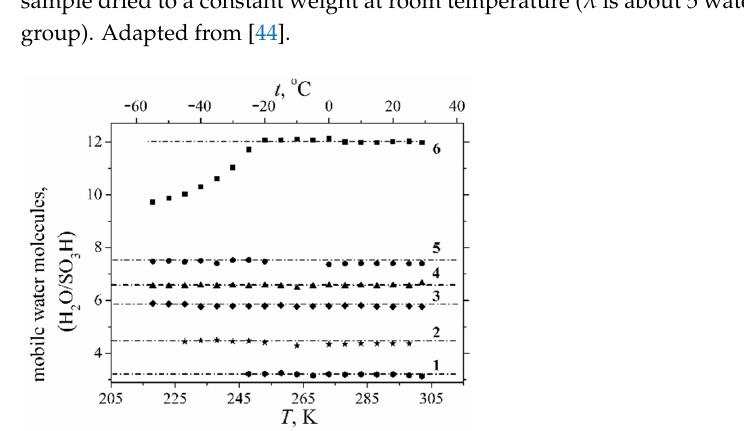
Figure 16. Dependences of the mobile water molecule amount in the acidic form of the Nafion 117 membrane on temperature at different water contents: (1) λ = 3.2 ± 0.4; (2) λ = 4.4 ± 0.4; (3) λ = 5.8 ± 0.4; (4) λ = 6.4 ± 0.4; (5) λ = 7.4 ± 0.4; (6) λ = 12 ± 0.4. Reprinted with permission from Ref. [41]. Copyright © 2022 Springer-Verlag GmbH Austria, part of Springer Nature.